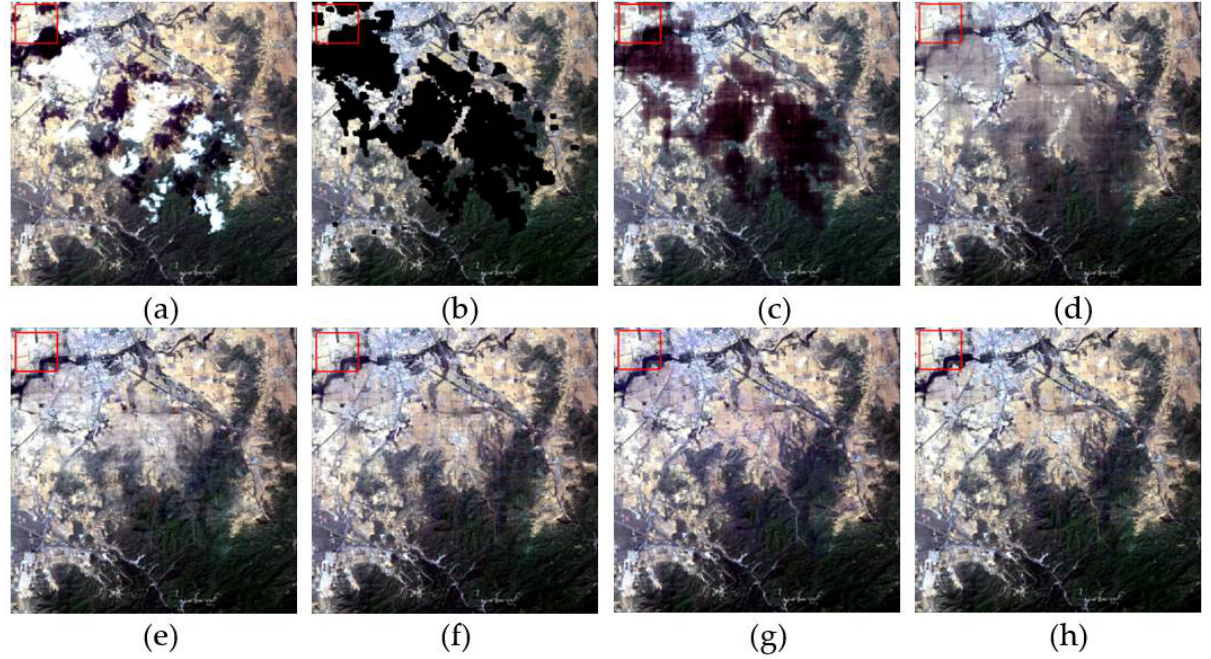
Figure 16. The real data experiment performed on dataset 6: ( a ) original image; ( b ) masked image; ( c – h ) reconstructed images for HaLRTC, AWTC, NL-LRTC, TVLRSD, ST-Tensor and FMTC algo- rithms, respectively.